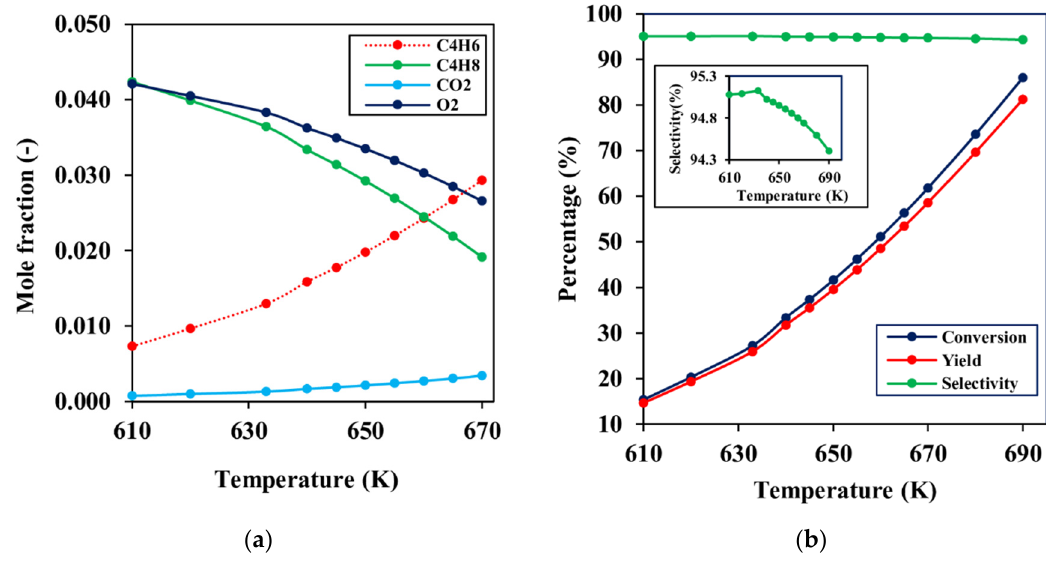
Figure 12. Mole fractions and reactor performance profiles as a function of temperature: ( a ) mole fractions; ( b ) conversion, yield, and selectivity.